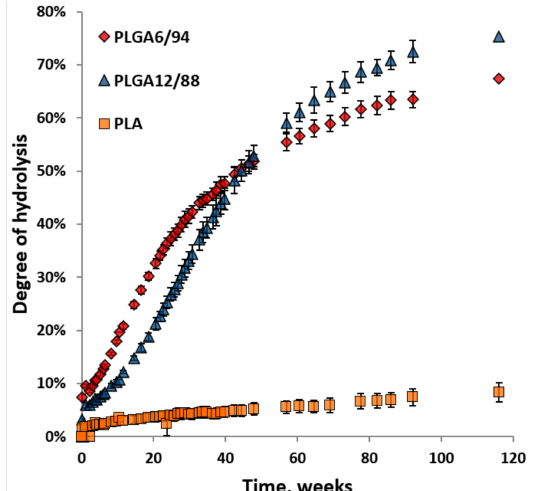
Figure 5. Degree of hydrolysis for PLGA6/94, PLGA12/88 and PLA versus time over 116 weeks at 25 ◦ C in D 2 O. The points represent the averages of triplicate experiments, with the error bars representing the standard deviation.